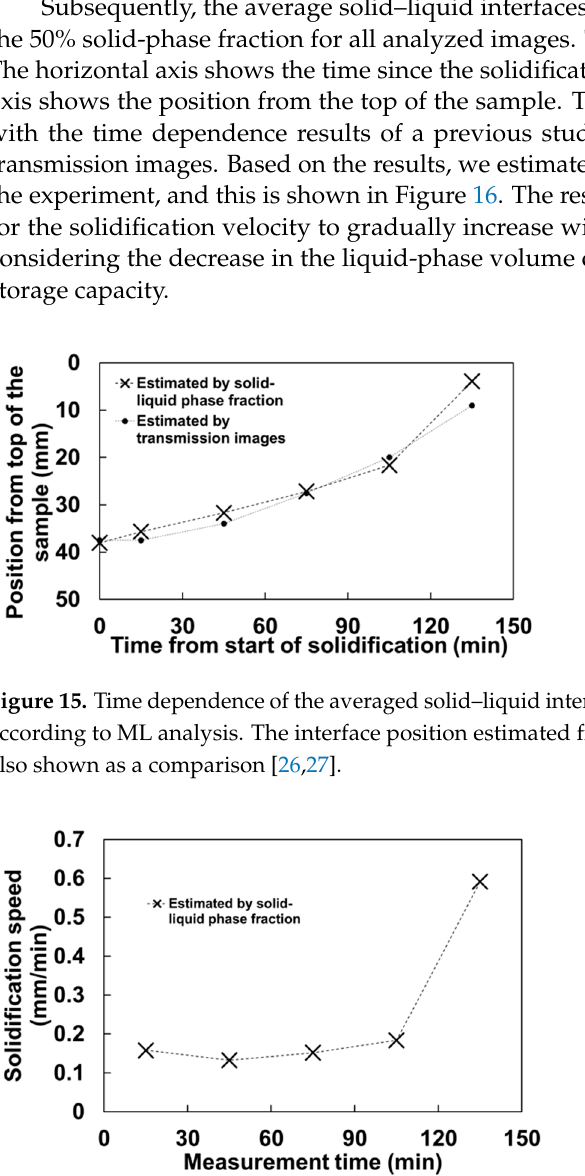
Figure 16. Solidification velocity estimated from the averaged solidification interface position ob- tained by ML analysis.